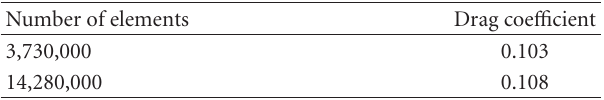
Table 1: Results of mesh-independence study, values of drag coe ffi - cient for the T7 device. Both calculations were completed for a Re =